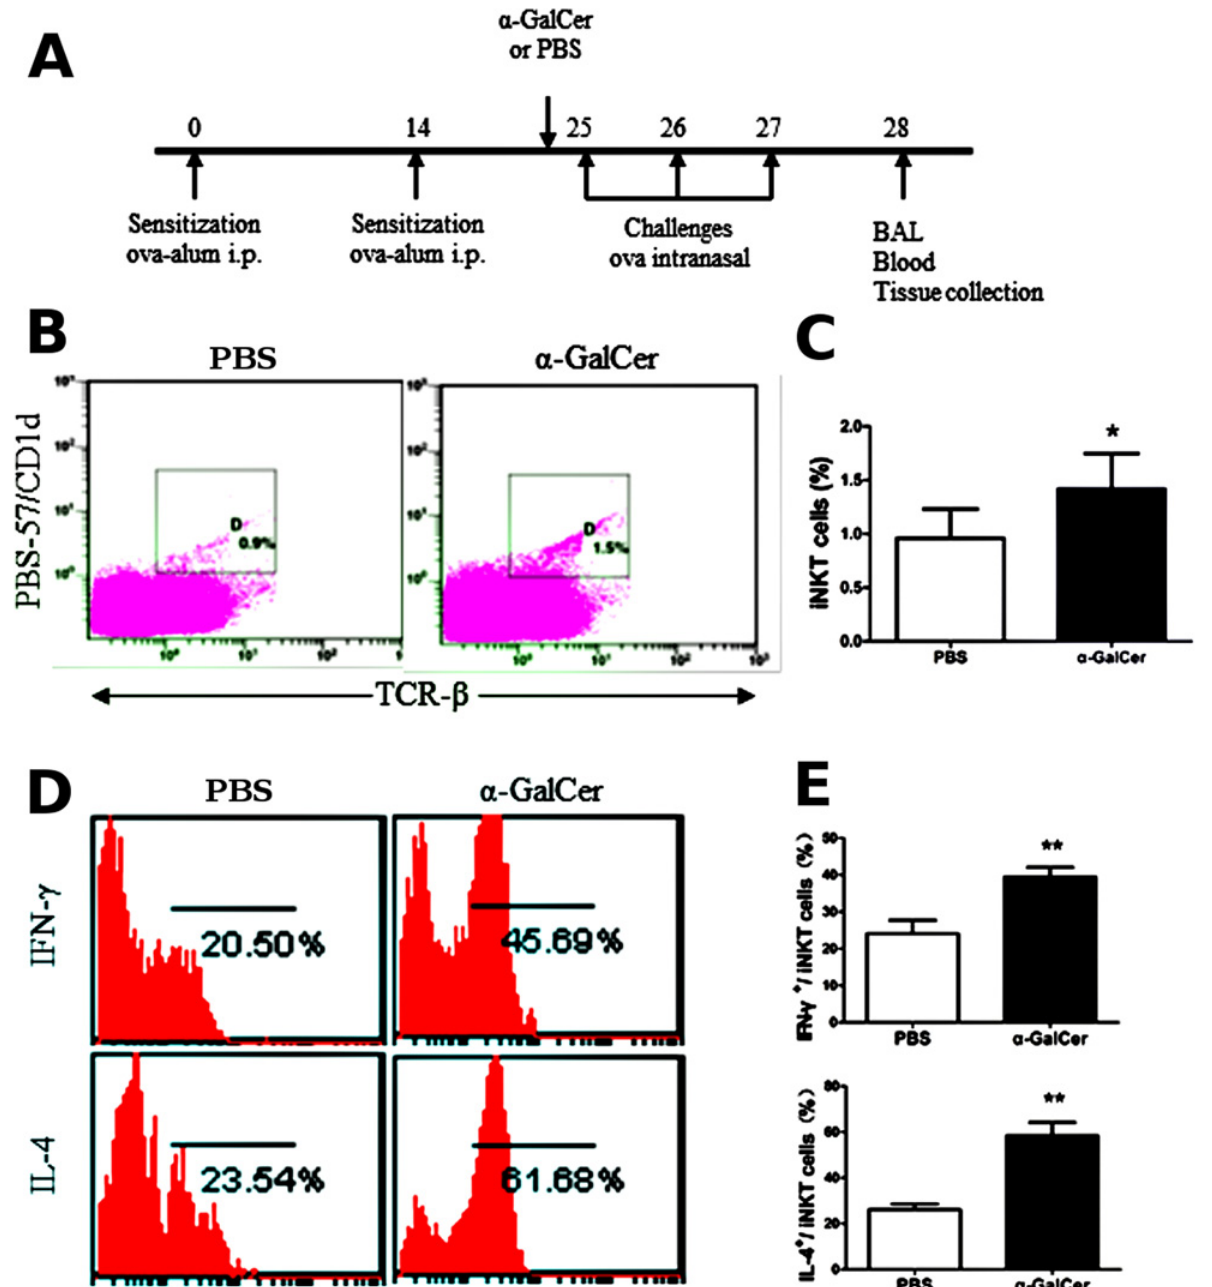
Fig 4. α -GalCer administration augments the activation of iNKT cells in OVA-induced asthmatic mice. A . Timeline of the OVA immunization/challenge protocol and the names of the treatment groups ( α -GalCer or PBS). Mice were sacrificed 24 h after the final challenge and the number and activity of iNKT cells was analyzed in the lung. B . Lung iNKT cells were confirmed by PBS/CD1d tetramers and TCR- β staining in asthmatic mice treated with α -GalCer or PBS using flow cytometry. The gating used for iNKT cells (gate D) and the corresponding percentages are shown in each dot plot. C . Percentage of iNKT cells in lung MNCs from asthmatic mice treated with α -GalCer or PBS. N = 5 per group and * P < 0.05. D . Lung iNKT cells producing IFN- γ and IL-4 from asthmatic mice treated with α -GalCer or PBS. PBS-57/CD1d and TCR- β double-positive cells were examined for IFN- γ (top) and IL-4 (bottom) secretion. Numbers in each dot plots indicate the percentage of positive cells. E . Percentage of IFN- γ - and IL-4-expressing lung iNKT cells from asthmatic mice treated with α -GalCer or PBS. N = 5 per group and ** P < 0.01.